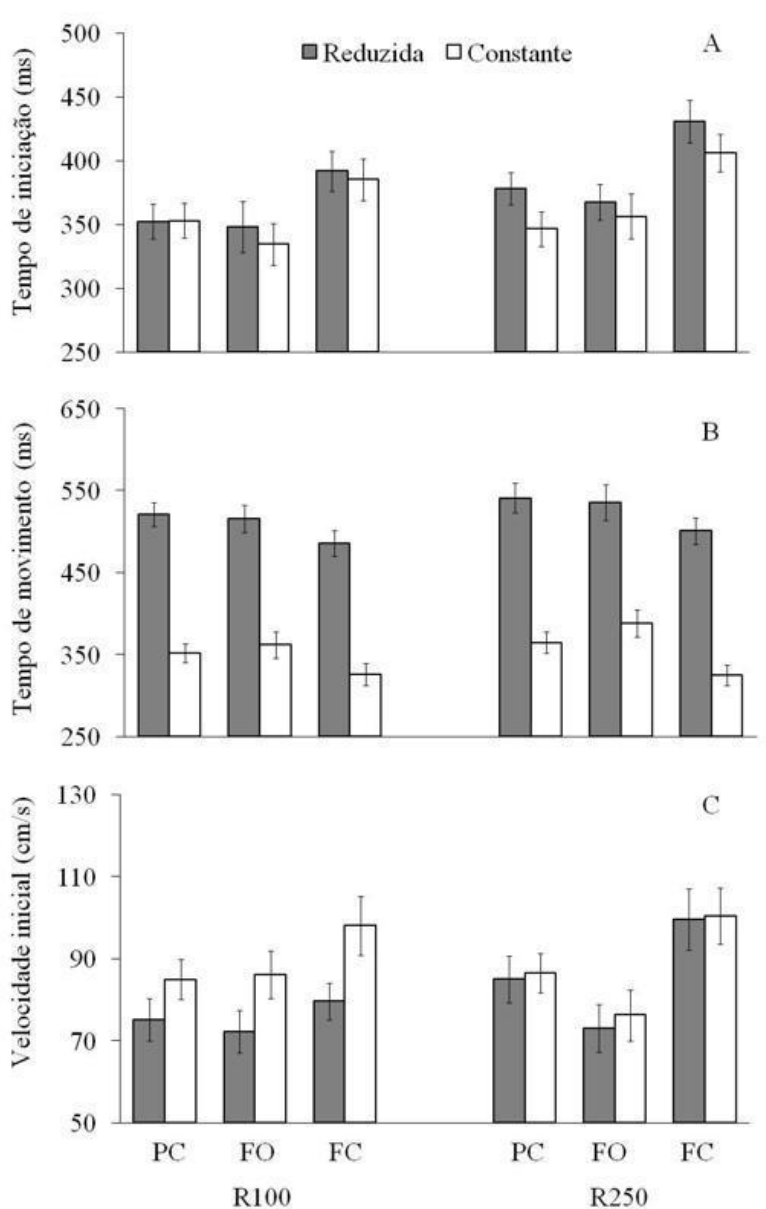
Figura 3. Valores Médios (ms) do Tempo de Iniciação (A), Tempo de Movimento (B) e Velocidade Inicial do Movimento (C), em Função da Condição Visual, Velocidade e Tempo de Redução de Velocidade; Traços Verticais Representam o Erro